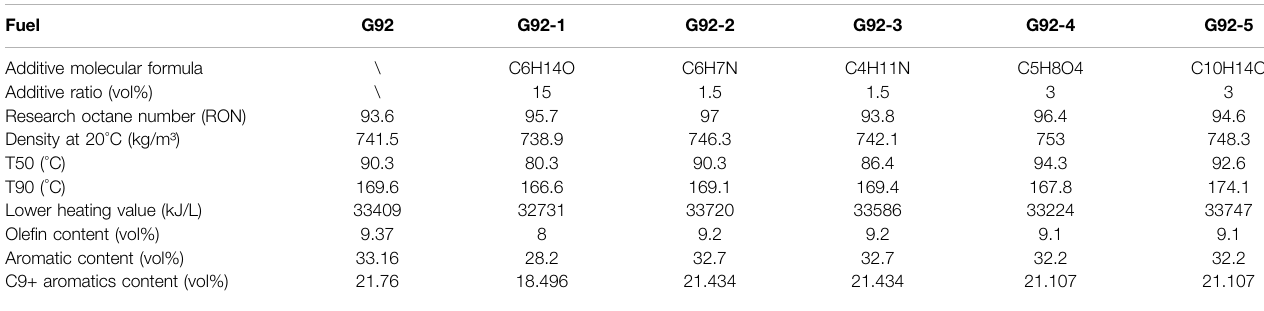
TABLE 4 | The fuel properties of the test fuels.